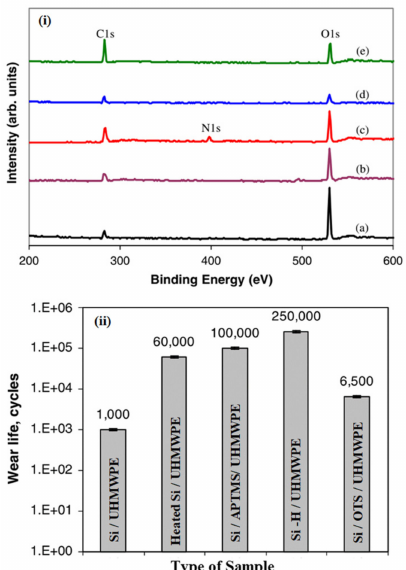
Figure 6. ( i ) XPS spectrum for ( a ) bare Si, ( b ) heated Si, ( c ) Si/APTMS, ( d ) Si-H, ( e ) Si/OTS ( ii ) Wear life behaviour for different samples [57]. Reproduced with permission from Myo Minn, Leong Yonghui Jonathan and Sujeet K Sinha, J. Phys. D: Appl. Phys; published by IOP Publishing,